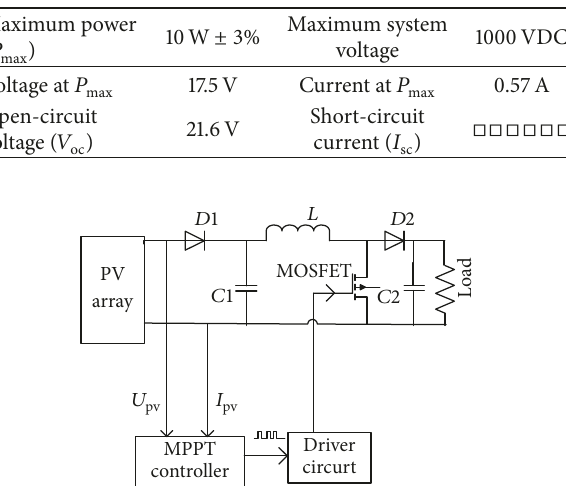
Table 2: Parameters of solar cell.